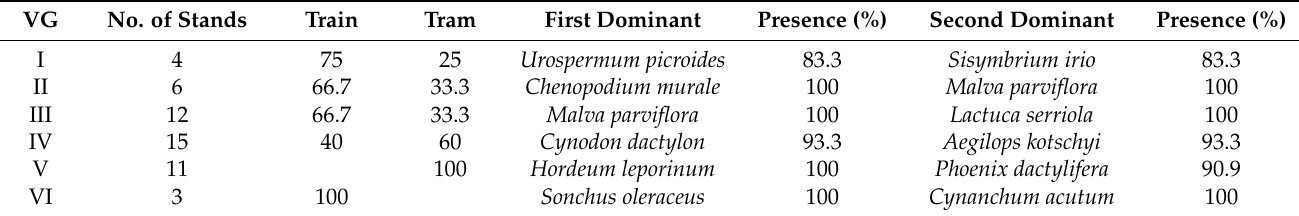
Table 1. Characteristics of the 6 vegetation groups derived after application of TWINSPAN. The vegetation groups are named as follows: I: Urospermum picroides , II: Chenopodium murale , III: Malva parviflora , IV: Cynodon dactylon , V: Hordeum leporinum , and VI: Sonchus oleraceus